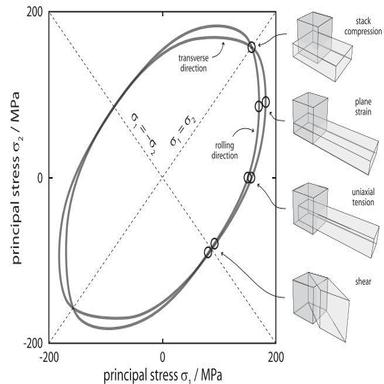
The VEGTER yield surface derived from virtual test data. The corresponding associated individual simulated or experimentally conducted deformation tests are schematically depicted on the right hand side. Figure adopted from with permission from Elsevier.